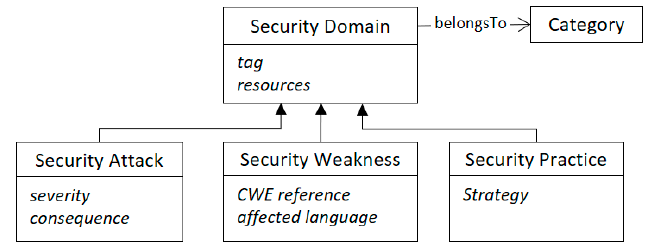
Figure 3. Security domain Model.